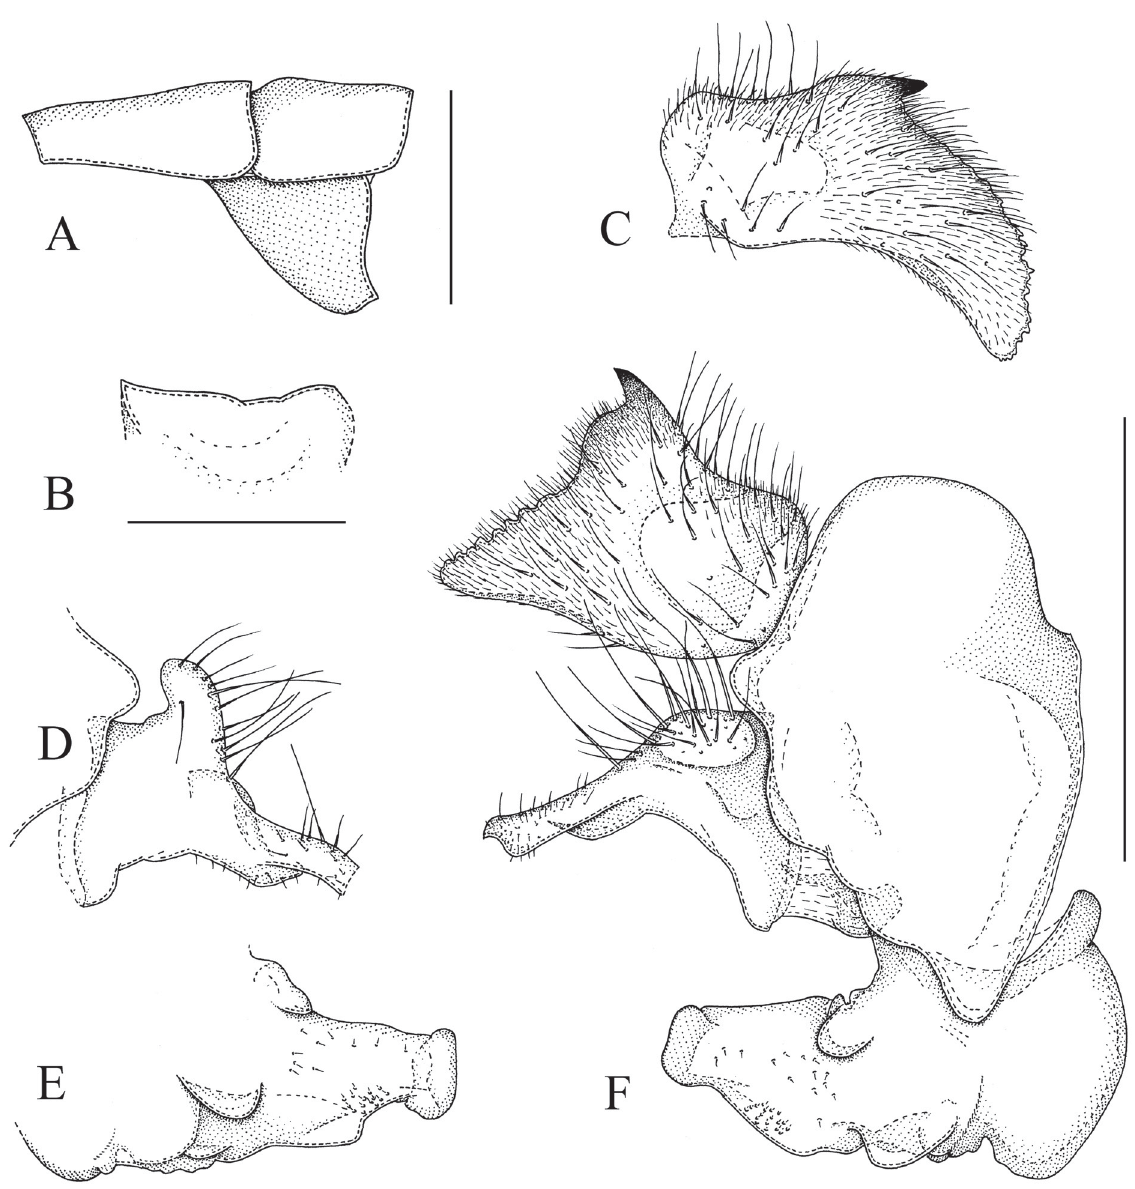
Fig. 26. Sphegina (Asiosphegina) dentata sp. nov., holotype, ♂ . A . Terga III and IV and ste rnum IV, left side lateral view. B . Sternum IV, ventral view. C . Left cercus, lateral view. D . Left surstylus, lateral view. E . Left superior lobe with associated parts, lateral view. F . Genitalia, right side, lateral view. Scale bars = 0.5